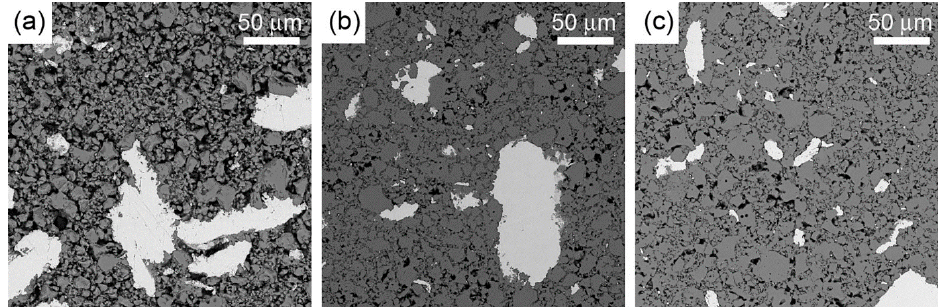
Figure 4. Representative backscattered SEM images of the surface of TCP–Fe composite after spark plasma sintering at ( a ) 900 °C, ( b ) 1000 °C and ( c ) 1100 °C. The distribution of the two components can be observed, i.e., iron in bright and ceramic in dark grey.